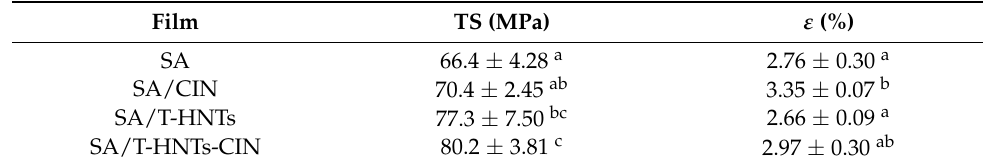
Table 3. Mechanical properties of SA nanocomposite